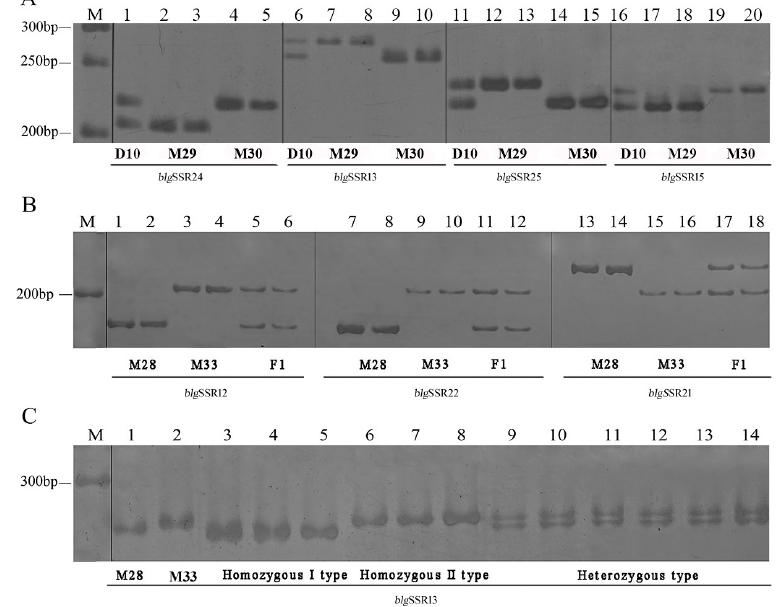
Figure 2. Examples of expressed sequence tag-simple sequence repeat markers applied in